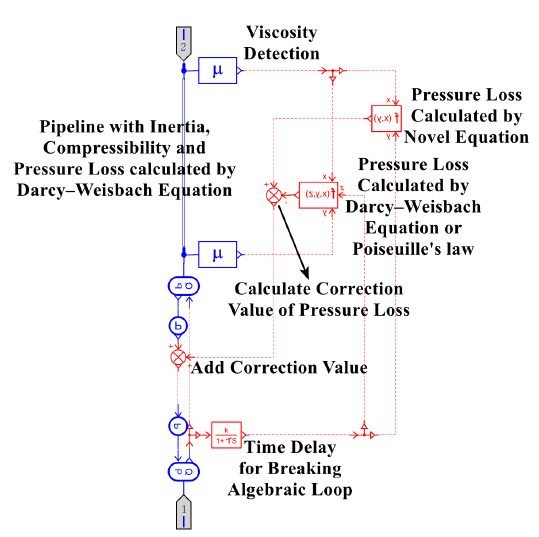
Figure 6. Model of slender